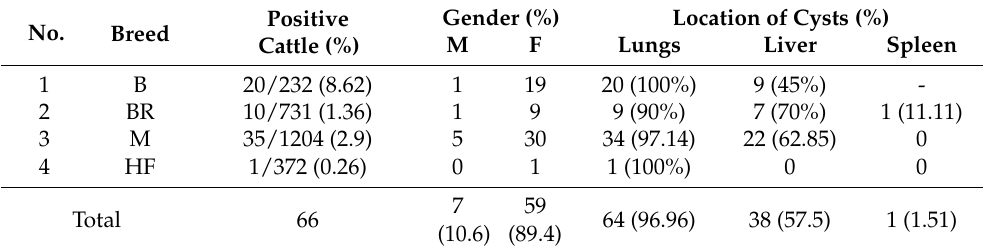
Table 2. Prevalence and locations of cysts in different breeds of cattle.